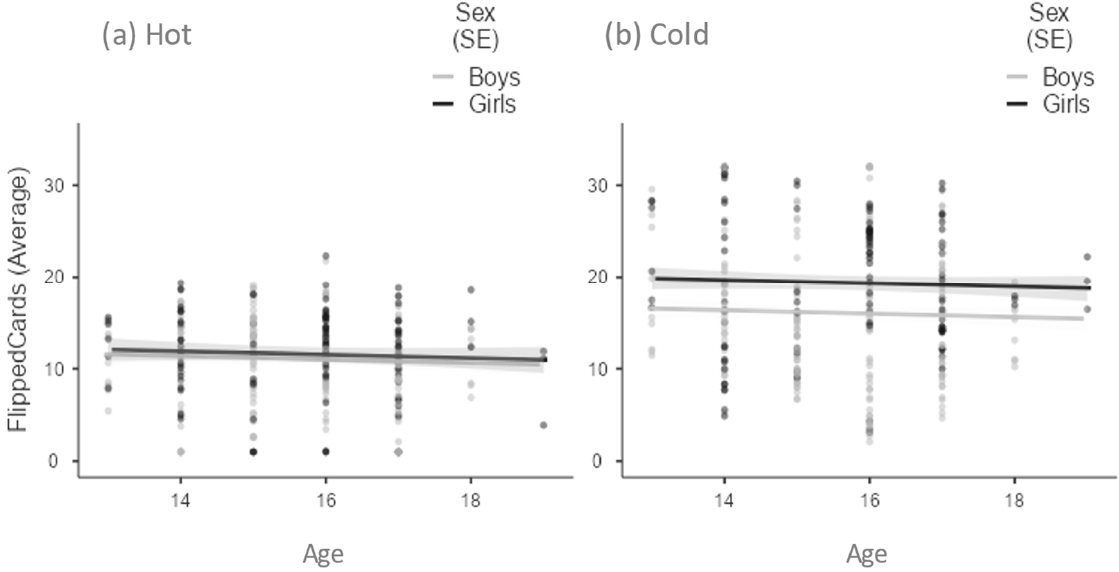
Figure 2. Average number of flipped cards per trial in the ( a ) Hot and ( b ) Cold Columbia Card Task as a function of age and gender.